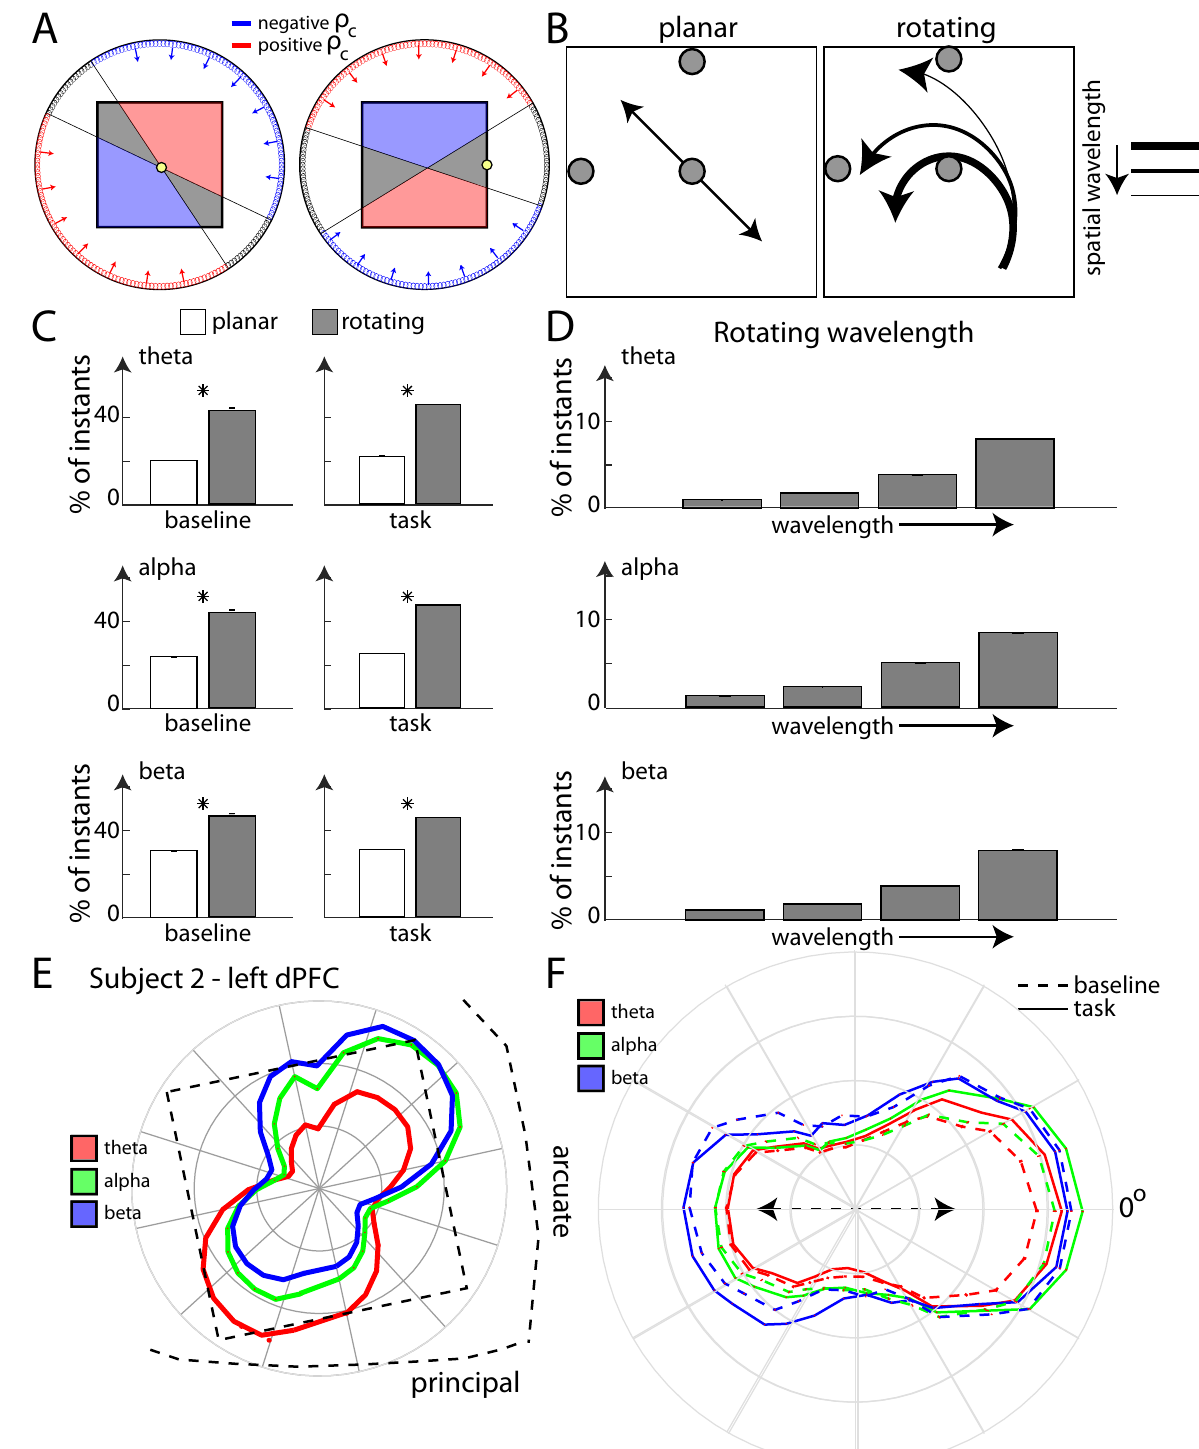
Fig 3. (A) Schematic illustrating the function of the circular-circular correlation coefficient ( ρ c ) around a particular point (yellow circle). Two different positions of the point are shown. A positive ρ c is calculated for the waves toward the red part of the array (red vectors), while blue gives a negative ρ c . The grey zone denotes wave directions that gave a correlation coefficient value within the “chance zone”. The zones differ with choice of point (right vs left panel) (B) Two broad wave types–planar (left) and rotating (right) waves were classified. Finer distinction possibilities are